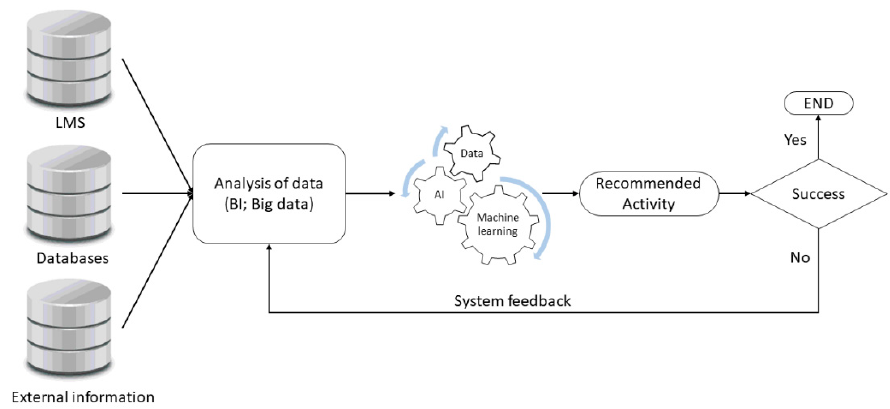
Figure 4. Big data integration model—Machine learning and LMS.